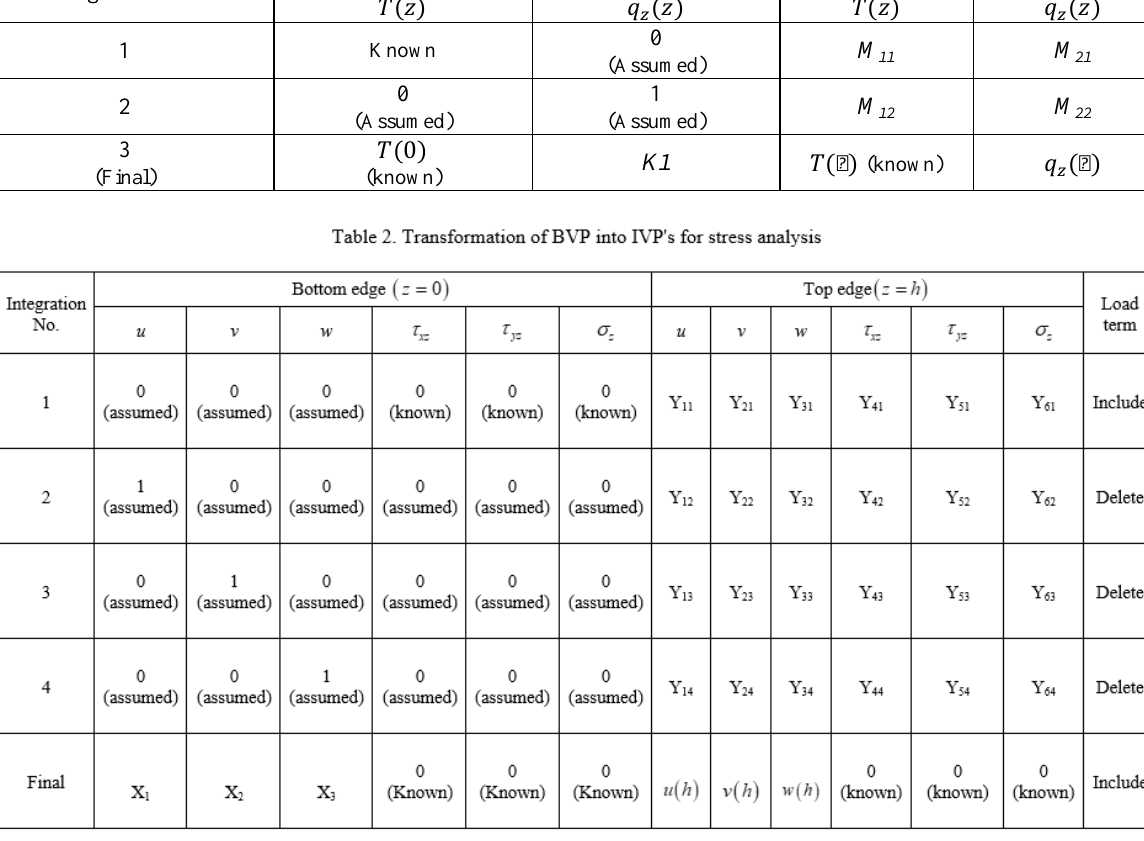
Transformation of BVP into IVP's for thermal analysis Integration No.